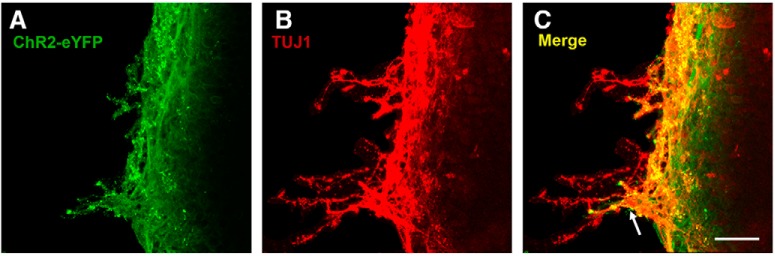
Neurites of ChR2-RGCs are observed in the outgrown neurites of the P11 ChR2 retinal explant. A, eYFP antibody was used to enhance ChR2-eYFP signal from ChR2-RGCs in the retinal explant. B, Recognized neurites of the retinal explant were all TUJ1-positive. C, The white arrow shows the colocalization of ChR2-eYFP and TUJ1 signals indicating that some outgrown neurites were from ChR2-RGCs. Scale bar, 100 μm.